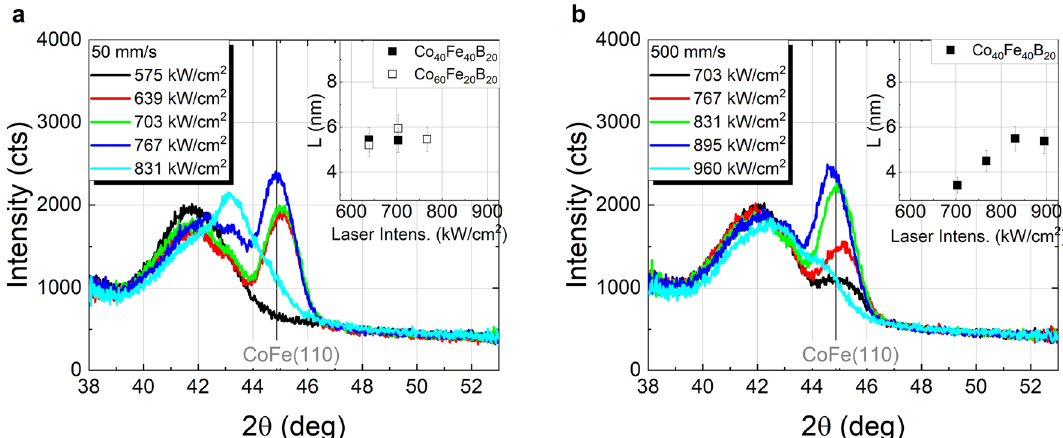
Figure 2. XRD θ -2 θ scans of Co 40 Fe 40 B 20 annealed by cw laser irradiation in dependence of laser intensity at different scanning speeds: ( a ) 50 mm/s and ( b ) 500 mm/s. The vertical coherence lengths ( L ) determined from the CoFe(110) peak are shown in the insets.